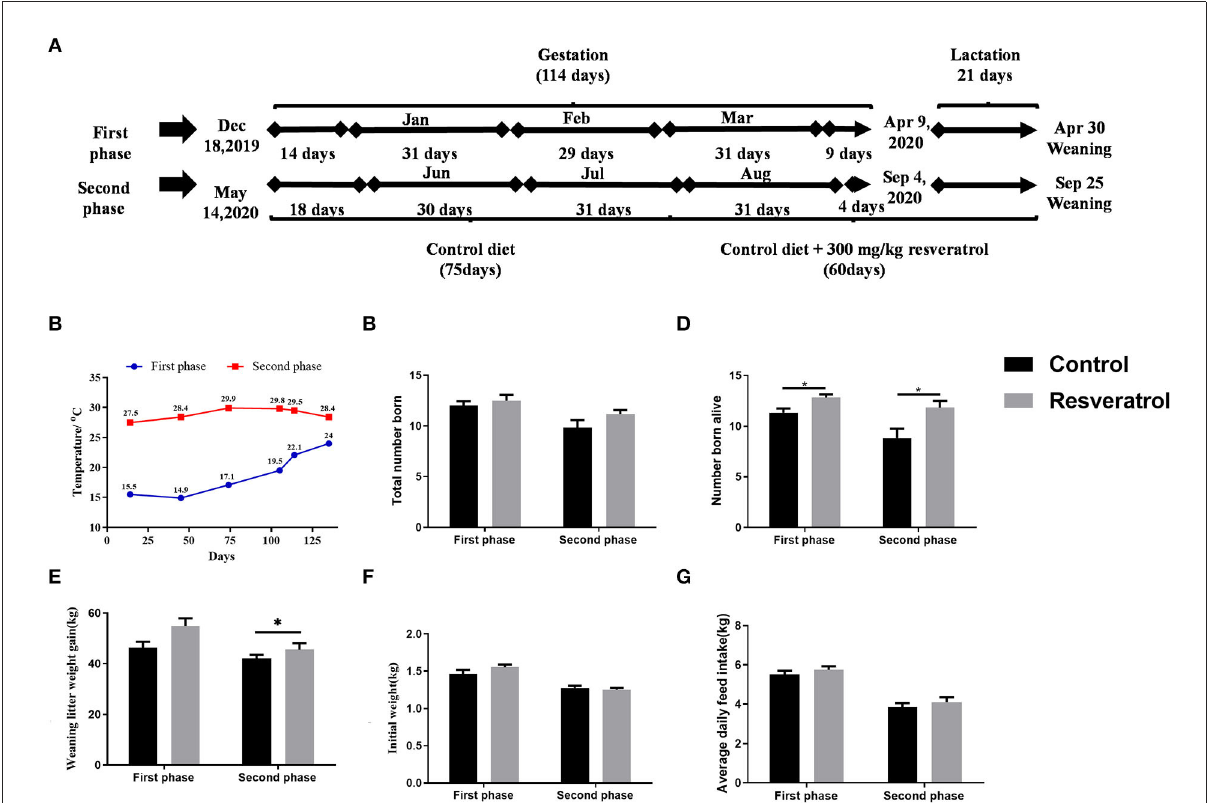
FIGURE1 Effects of dietary resveratrol supplementation during gestation and lactation on the reproduction performance of sows. Data were expressed as means ± standard error of the mean (SEM) of at least three independent experiments. (A) Schematic diagram of the research design. (B) The temperature of the hog house. (C) Total number of births. (D) Number of live births. (E) Litter weight gain at weaning. (F) Initial weight. (G) Average daily feed intake of sows. * p <